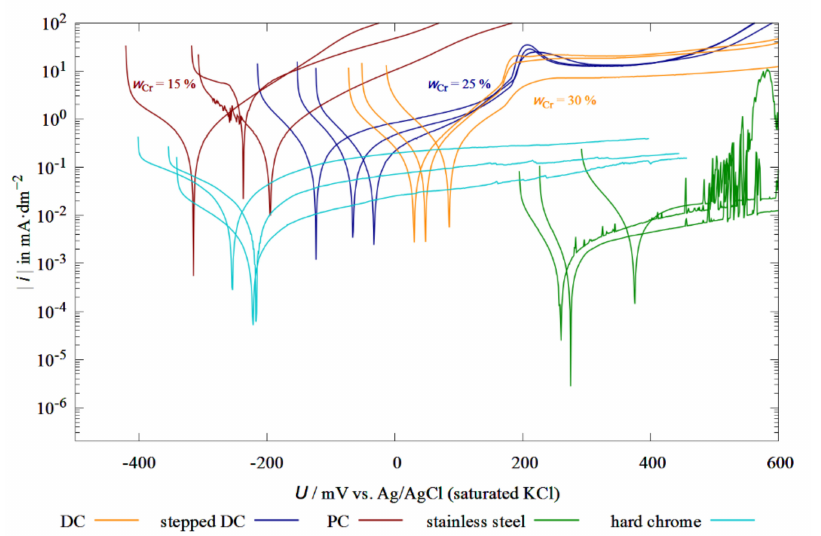
Figure 10. Current-density–potential curves of Fe-Cr-Ni layers and hard-chrome layers in 3.5% NaCl